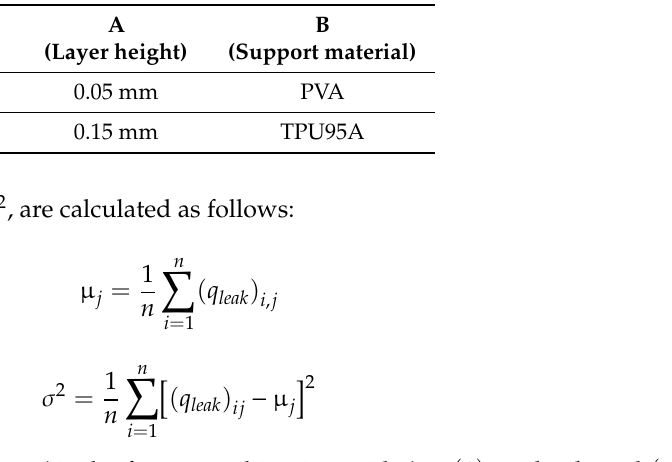
Table 2. For the factors and levels